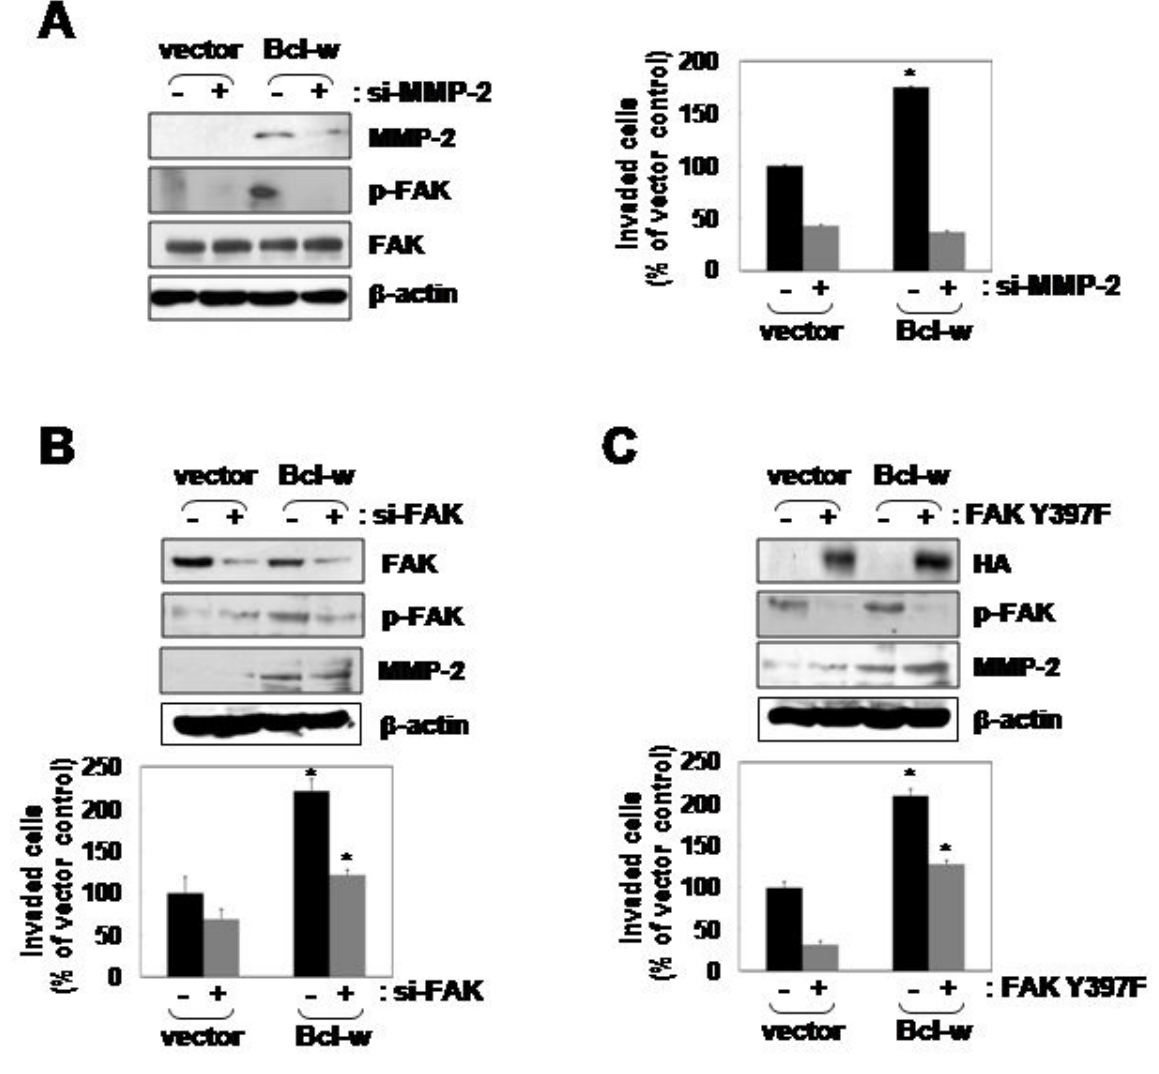
Figure 6. Activation of MMP-2 and FAK mediates Bcl-w-induced invasion upstream of FAK. A , right image, MMP-2 siRNA (20nM) was introduced into the indicated U251 transfectants, and after 24 hours of incubation, p-FAK (Y397) and MMP-2 protein levels were compared using Western blotting. Left image, invasion assays were performed using small interfering RNA MMP-2- treated and untreated cells. *, p< 0.01 versus untreated control, n = 5. B , top image, FAK siRNA was introduced into the indicated transfectants, and after 24 hours of incubation, cellular levels of FAK, p-FAK and MMP-2 compared using Western blotting. Bottom plots, invasion assays were conducted using the indicated cells. *, p< 0.05, n = 5. C , top images, vector- and Bcl-w-expressing cells were transiently transfected with expression vectors for HA-tagged dominant-negative FAK mutant (FAKY397F). After 24 hours of incubation, expression of the introduced mutants in cells was verified by Western blotting. Bottom plots, invasive potentials of the indicated cells were compared. *, p < 0.05, n =